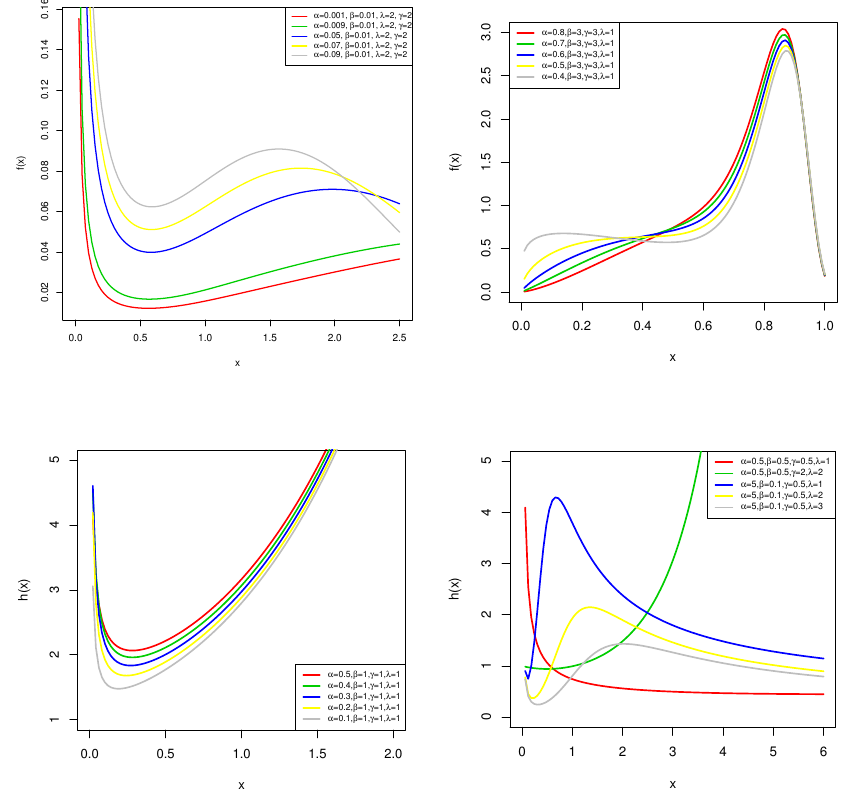
Figure 2. The pdf and hrf plots of the AOLLOW-W